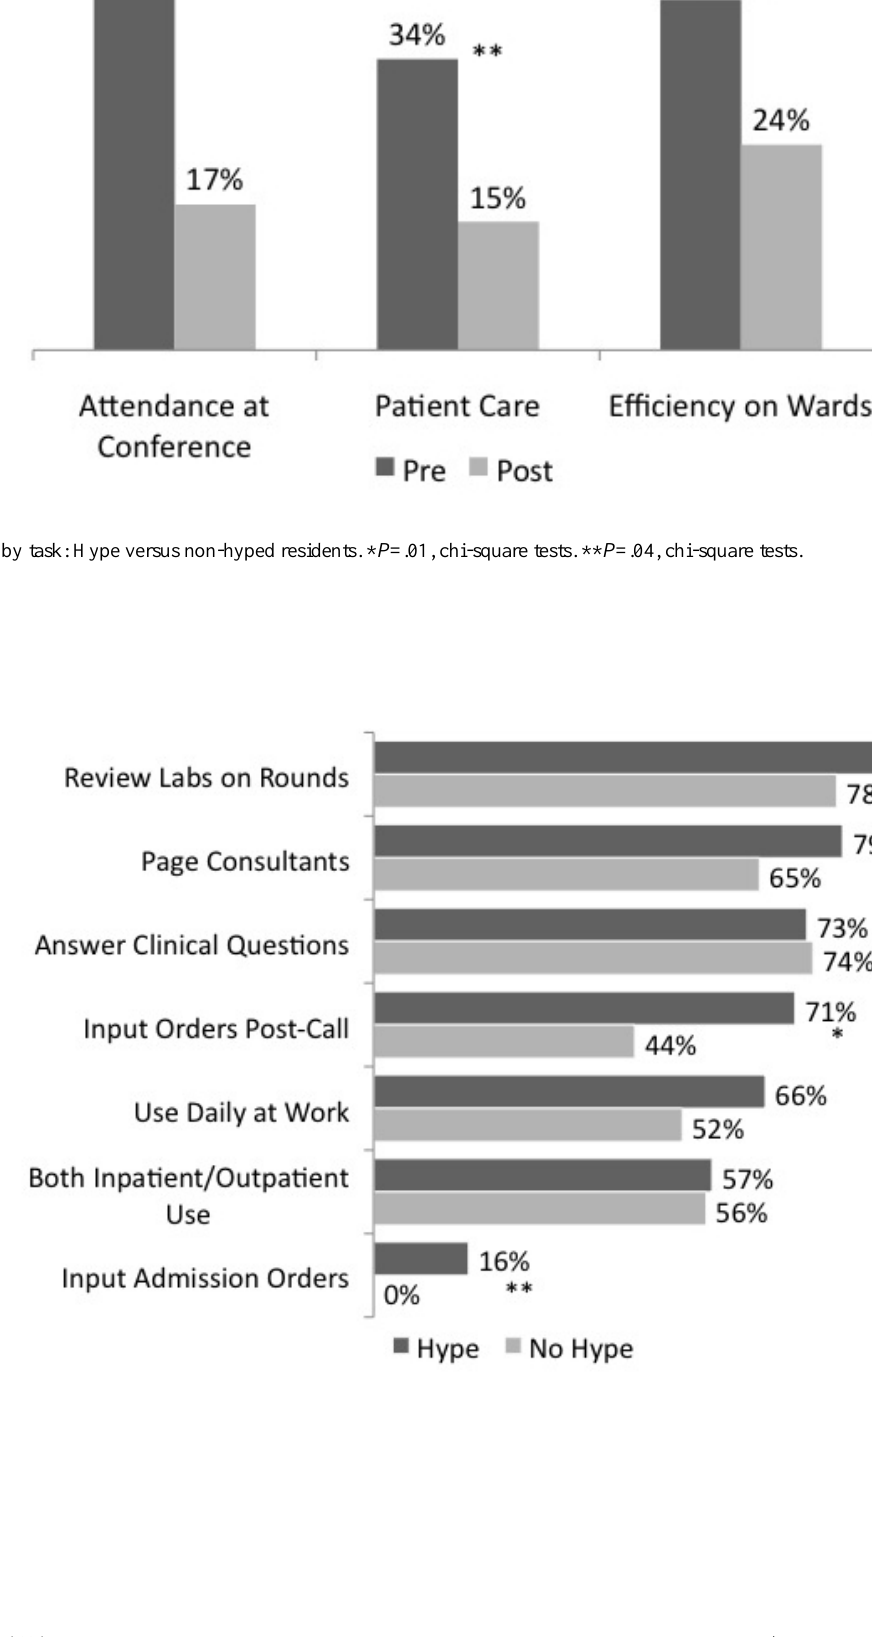
Figure 2. Expectations of iPad use. * P =.005, 2-sample tests of proportion. ** P <.001, 2-sample tests of proportion.